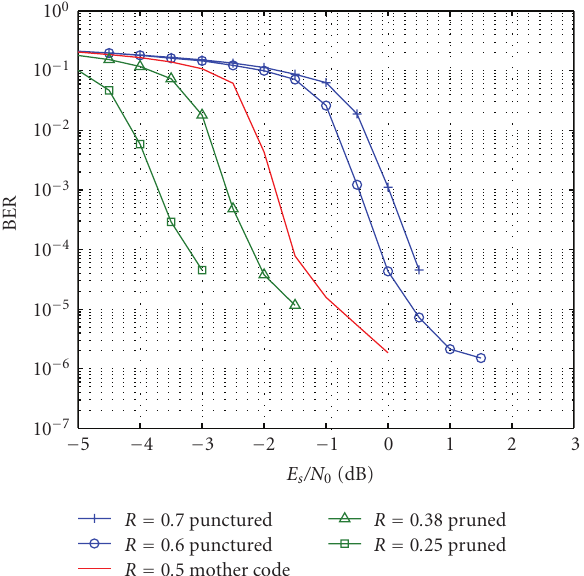
Figure 5: Set of bit-error rate curves of pruned and punctured Turbo codes built from RSC codes (for parameters, see the